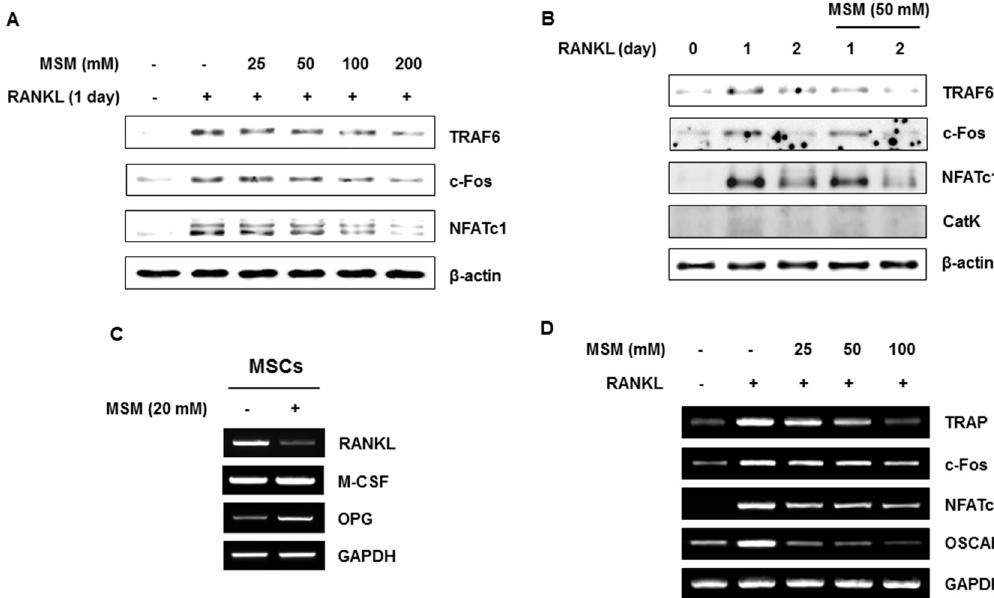
Fig 2. MSM suppresses RANKL-induced osteoclast marker gene and protein expression. BMMs were cultured in the presence of M-CSF (30 ng/ml) and RANKL (100 ng/ml) for the indicated number of days, with or without various concentrations of MSM. (A and B) Expression levels of the RANKL-induced osteoclast marker proteins examined by western blot analyses. (C) Expression of mRNAs for RANKL and OPG in bone marrow mesenchymal stem cells (MSCs). (D) Expression of mRNA for RANKL-induced osteoclast marker genes examined by RT-PCR analyses. Beta-actin and GAPDH were used as loading controls. Data shown are representative of three independent